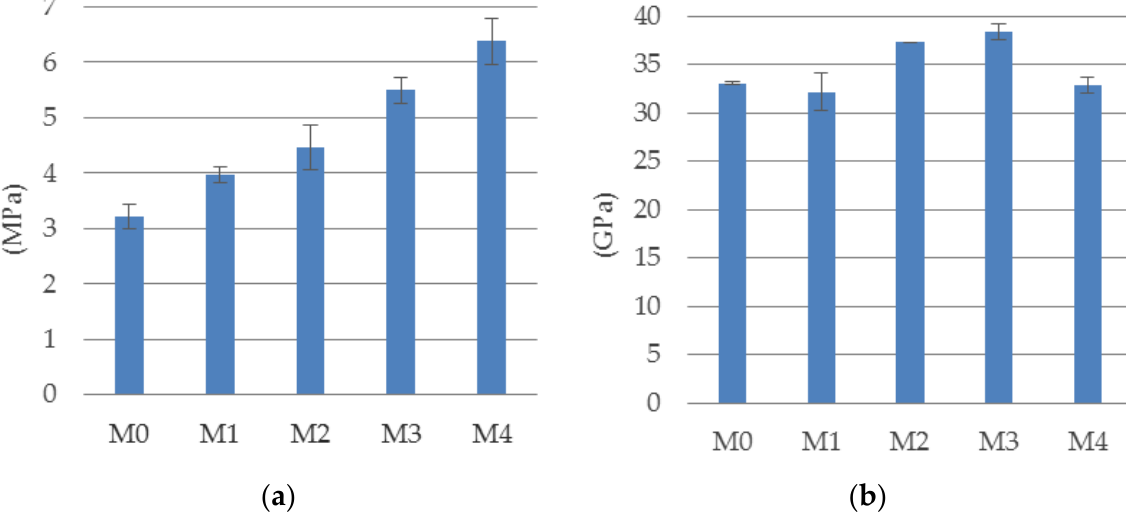
Figure 5. ( a ) Splitting tensile test results (on cubic samples); ( b ) stiffness modulus, both after 28 days. This is a typical effect observed in connection with the problem of effective homog- enization of concrete at high fiber dosages, which may lead to local disturbances in the structure of the samples. Many researchers report about the different effects of fibers on compressive strength of composite materials. Larsen and Thorstensen [39] show that at a point, increasing the fiber content could have an adverse effect on the compressive strength. Meng and Khayat [40] reported this effect when the fiber content exceeded 3% by